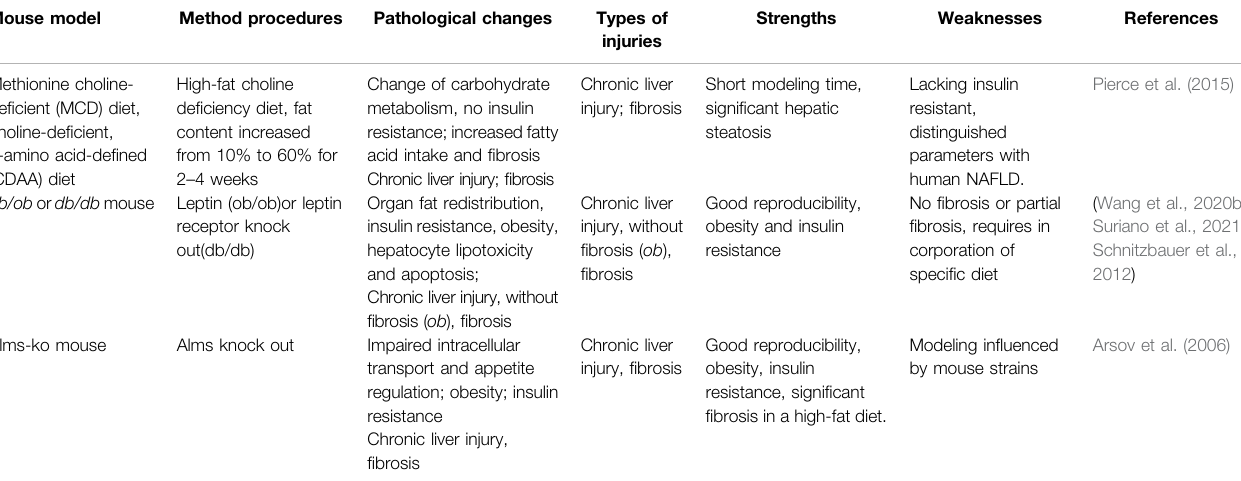
TABLE 3 | Mouse models of non-alcoholic fatty liver diseases